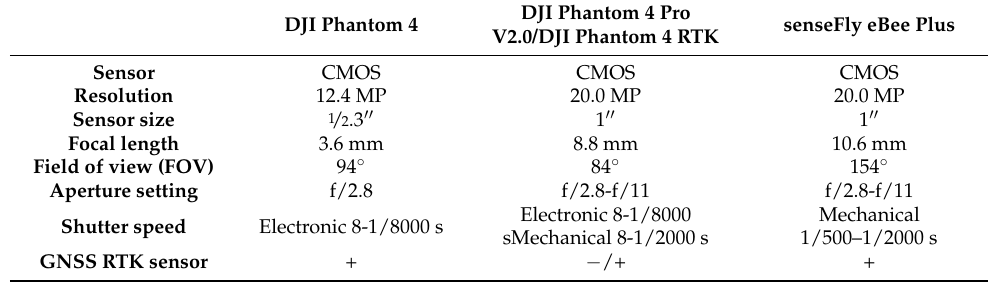
Table 2. UAS camera specifications.